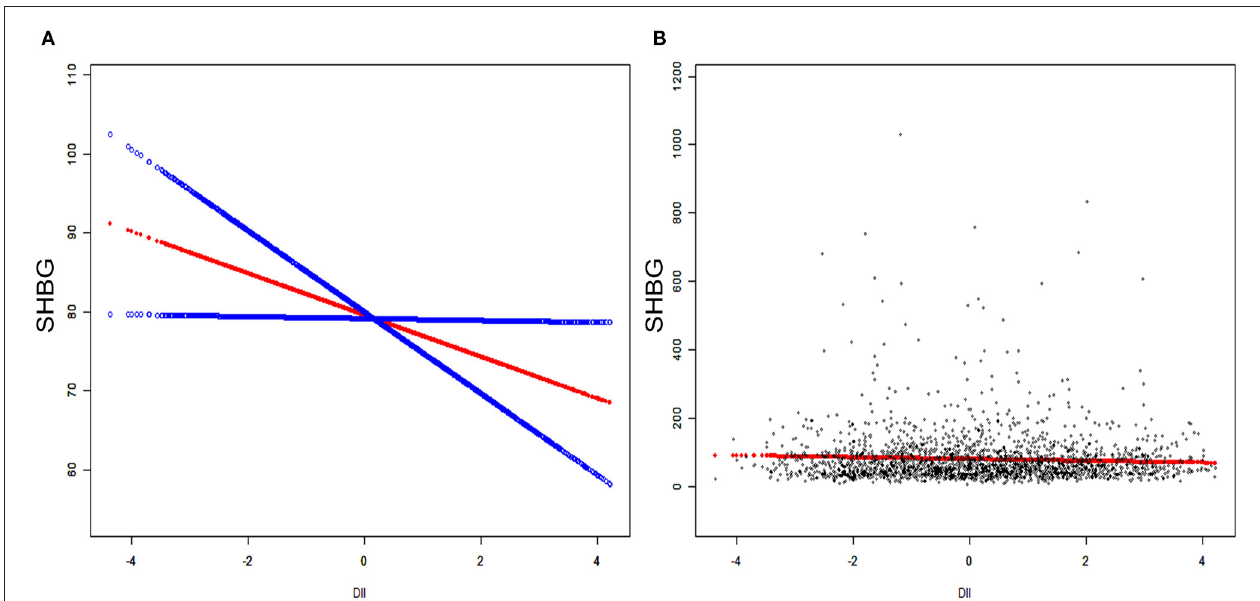
FIGURE 2 | The association between serum DII and SHBG. (A) Blue bands represent the 95% CI from the fit. The solid rad line represents the smooth curve fit between variables. (B) Each black point represents a single participant SHBG sample.